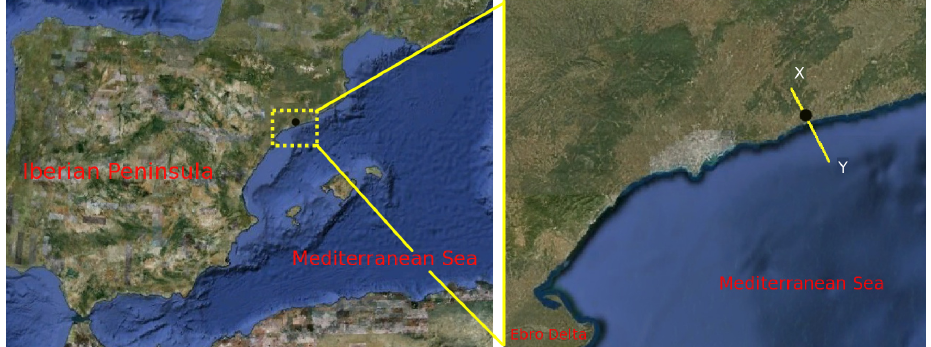
Figure 1. The western Mediterranean area (left) and enlargement of the studied region (right). The yellow line marks the cross section where the wind field is analyzed in section 2.1